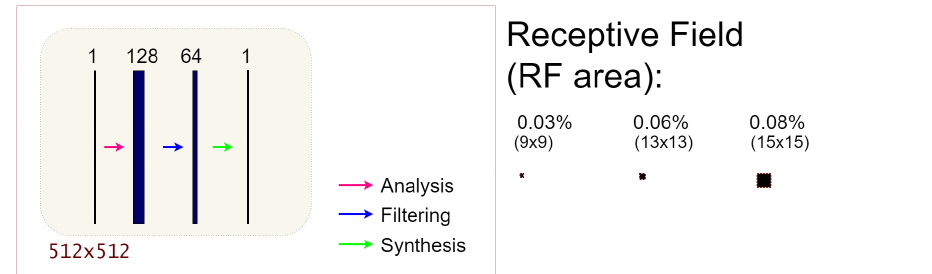
Figure 4. On the left : graphical representation of the 3L-SSNet architecture; on the right : details on the receptive fields for each of the three layers of the network (RF percentage respect to the input 512 × 512 image and size of RF). The name of the three layers follows the notation in